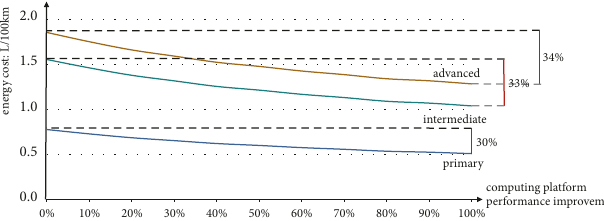
Figure 6: Fuel consumption cost of intelligent vehicle under computing platform performance